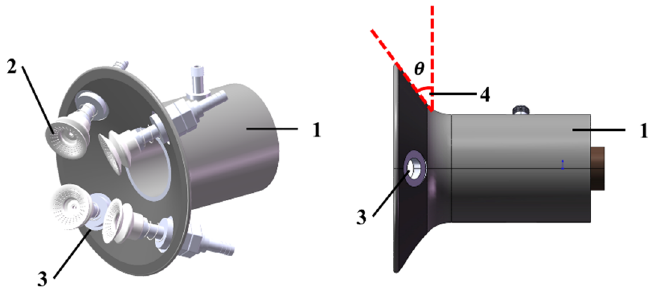
Figure 17. Mechanical hand: 1. mechanical hand; 2. suction cups; 3 mounting holes; 4. suction cup installation angle.